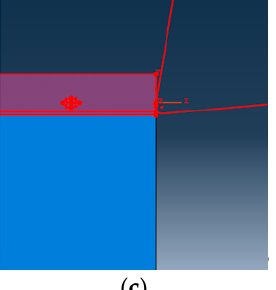
Figure 14. Three different positions of particles, ( a ) particle below the line, ( b ) particle on the line, and ( c ) particle above the line.